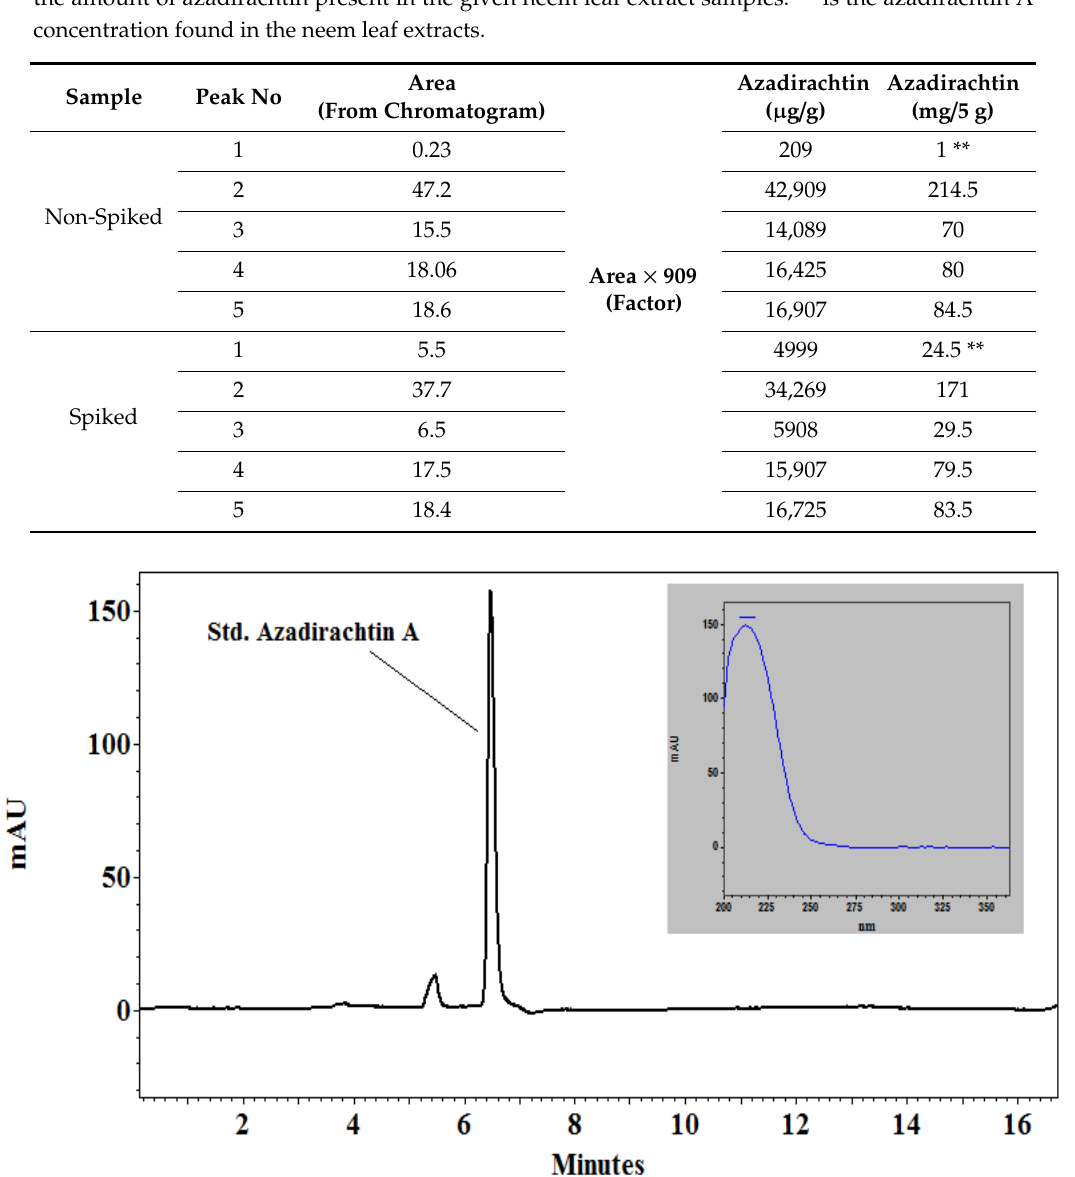
Figure 1. HPLC chromatogram of standard azadirachtin A.